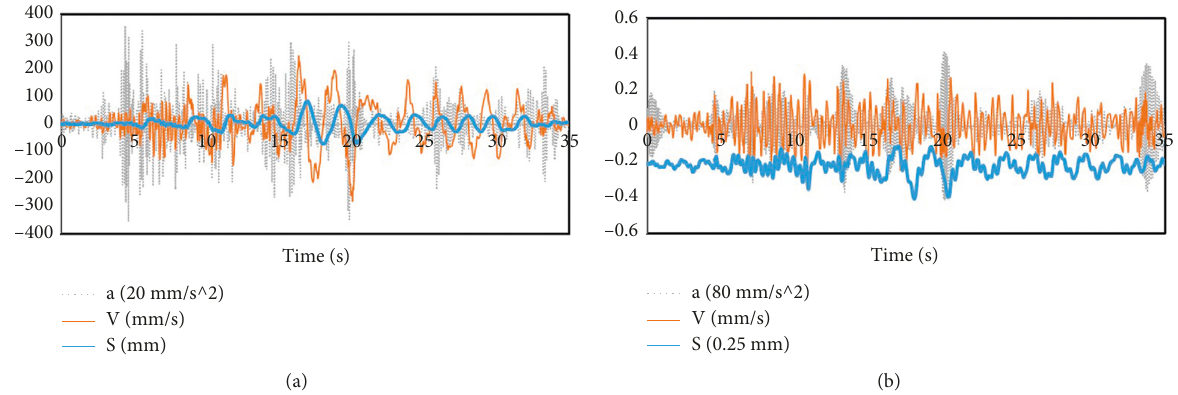
Figure 51: Time course curves of bearing deformation displacement, velocity and acceleration when LWD is input from X direction. (a) Horizontal deformation. (b) Vertical deformation.